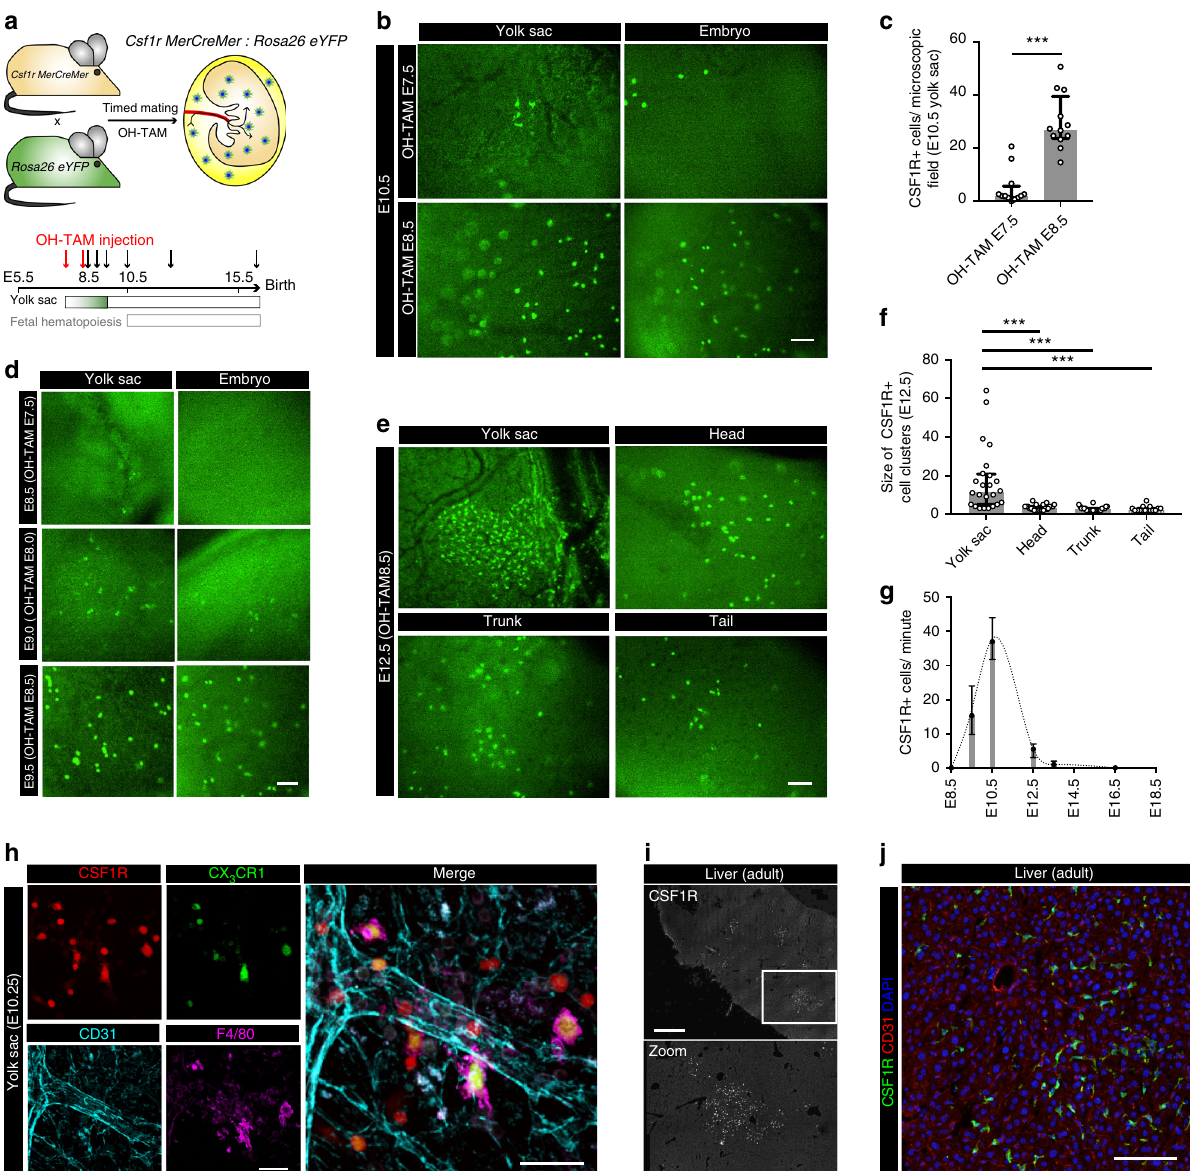
Fig. 6 Cellular expansion and morphology of CSF1R+ progenitors. a Schematic graph for the Csf1r MerCreMer :Rosa26 eYFP mouse model with OH-TAM pulse labeling at E7.5 or E8.5 (red arrows) and subsequent analyses at indicated time points (black arrows). b , c Fluorescence pictures of E10.5 YS and embryo after OH-TAM pulse at E7.5 or E8.5 as indicated ( b ) with corresponding quanti fi cations c ; *** p < 0.001 (two-tailed Mann – Whitney test); median ± IQR. d Fluorescent pictures in the YS and embryo at E8.5, E9.0 and E9.5 with OH-TAM injection 24 h earlier. e , f Fluorescence pictures of a E12.5 YS and different embryonic regions after OH-TAM pulse labeling on E8.5 ( e ) with corresponding quanti fi cation of cluster size ( f ); *** p < 0.001 (Kruskal – Wallis test with Dunn ’ s multiple comparisons test); median ± IQR. g Quanti fi cation of intravascular cells at indicated time points in an average-sized vessel; median ± IQR. h Fluorescence pictures of a E10.25 YS in a Csf1r MerCreMer :Rosa26 tdTomato (red) :Cx 3 cr1 GFP/ + (green) mouse model with OH-TAM pulse labeling at E8.5. Additional staining for F4/80 (purple) and CD31 (turquoise). i , j Adult liver sections of Csf1r MerCreMer : Rosa26 eYFP mice, pulse-labeled at E8.5 ( i ) with additional stainings for CD31 (red) and DAPI (blue) ( j ). Scale bars are 100 µ m ( b , d , e , j ), 1 mm ( i ), 50 µ m ( h lower than in E8.5 pulse-labeled Csf1r MerCreMer mice at E10.5, when traf fi cking reached its maximum (Figs. 6g and 7e). The difference might be explained by labeling of both EMPs and differentiating “ primitive ” macrophages in the Csf1r -dependent model. However, other factors such as differences in Cre recombination ef fi ciency might also play a role. In summary, the experiments indicate that of the different cell types labeled by applying a OH-TAM pulse, EMPs and their progeny represent an integral part traf fi cking from the YS to the embryo, which is in line with their role in seeding the fetal liver 13,16,46 .